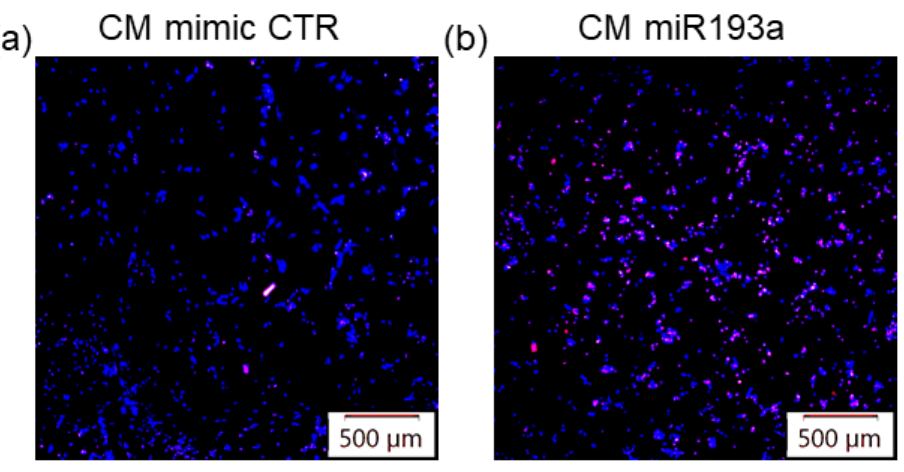
Figure 11. Secretome from miR193a-3p transfected MCF-7 cells induces death/apoptosis in LECs. Representative fluorescent photomicrographs depicting cells stained with propidium iodide (PI; reddish pink) and HOECHST 33342 (blue). Dead or apoptotic cells appear red while living cells appear blue. ( a ) LECs cultured in CM mimic CTR and ( b ) LECs cultured in CM miRNA193a. Live and dead/apoptotic cells were detected by fluorescence microscopy (4×; scale 500 μ m); n = 8.